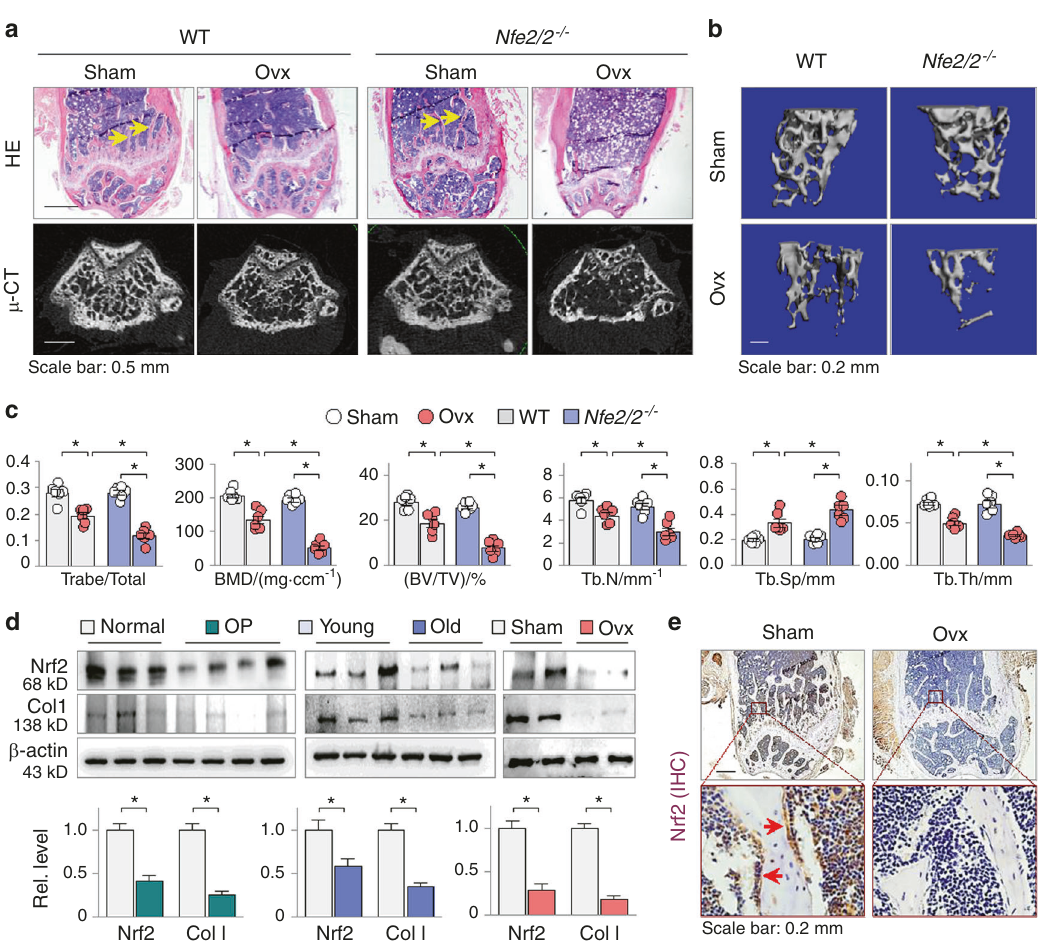
Fig. 1 Nrf2 is a critical antiosteoporotic factor suppressed in osteoporotic femurs. Representative photomicrographs of ( a ) H&E-stained (the upper panel, the arrows indicate trabeculae) and micro-CT-scanned ( μ -CT, the lower panel) distal femur sections and ( b ) micro-CT 3D trabecular architecture of distal femurs from the Nrf2 knockout mice ( Nfe2l2 − / − ) and wild-type littermates (WT) that underwent sham treatment or ovariectomy (Ovx) for 5 weeks (6 mice in each group). c Quantitative analysis of the ratio of sectional trabeculae over total area (Trabe/Total), microstructural bone mineral density (BMD, mg·ccm − 1 ), the ratio of bone volume to tissue volume (BV/TV), trabecular number (Tb.N), trabecular thickness (Tb.Th) and trabecular separation (Tb.Sp) of the μ -CT-scanned distal femurs in Fig. 1b. Data are presented as the mean ± SEM. * P < 0.05, two-way ANOVA. d Western blot analysis of Nrf2 and collagen 1 (Col 1) from the femoral homogenates of 3 healthy controls/4 patients with OP, sham/ovariectomized female mice, and young (3 months)/old (25 months) male mice (6 mice in each group, three or two randomly selected samples are shown). β -actin served as the internal control. WB quanti fi cations are shown underneath the blots. Relative values are presented as the mean ± SEM of all human and mouse samples. * P < 0.05, one-way ANOVA. e Representative femur sections of the sham and ovariectomized mice stained for Nrf2 by immunohistochemistry (IHC). The lower panel images are enlarged frames in the upper panel. The positively stained cells in brown are indicated by ovariectomized mice displayed typical osteoporotic alterations, such as reduced BMD, a lower trabecular bone volume versus tissue volume ratio (BV/TV), reduced trabecular bone number (Tb. N) and trabecular thickness (Tb.Th), increased trabecular bone separation (Tb.Sp) and reduced cortical thickness (Ct.Th, compar- ing groups 1 and 3 in Fig. 4a, the lower panel, and 4b). However, the RE effectively normalized the alterations (Fig. 4a, the lower panel, and b, comparing groups 4 and 3). Furthermore, femoral Nrf2 was suppressed in the ovariectomized mice, but RE signi fi cantly restored its level (Fig. 4c and d, upper panel). The osteoporotic femurs of the ovariectomized mice exhibited decreased levels of collagen 1 and the major osteoblast markers osteocalcin and Runx2 (Fig. 4c, d and e), as well as increased levels of the osteoclast marker TRAP (Fig. 4e). However, RE signi fi cantly corrected the abnormal expression, indicating that Nrf2 preservation by RE might exert an osteoprotective effect by inversely enhancing osteoblastogenesis and inhibiting osteoclastogenesis.